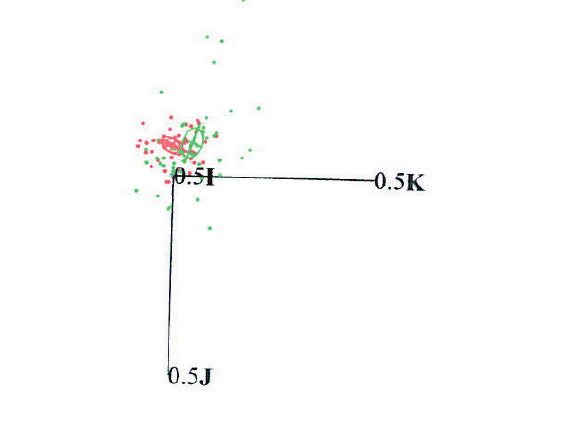
Figure 2. The scatter plot of figure 1 is viewed along the stigmatic, I , axis. This orientation emphasizes antistigmatic variation. The increased antistigmatic variation in the dark (green) is apparent. Also shown are the 95% confidence ellipsoids on the mean.